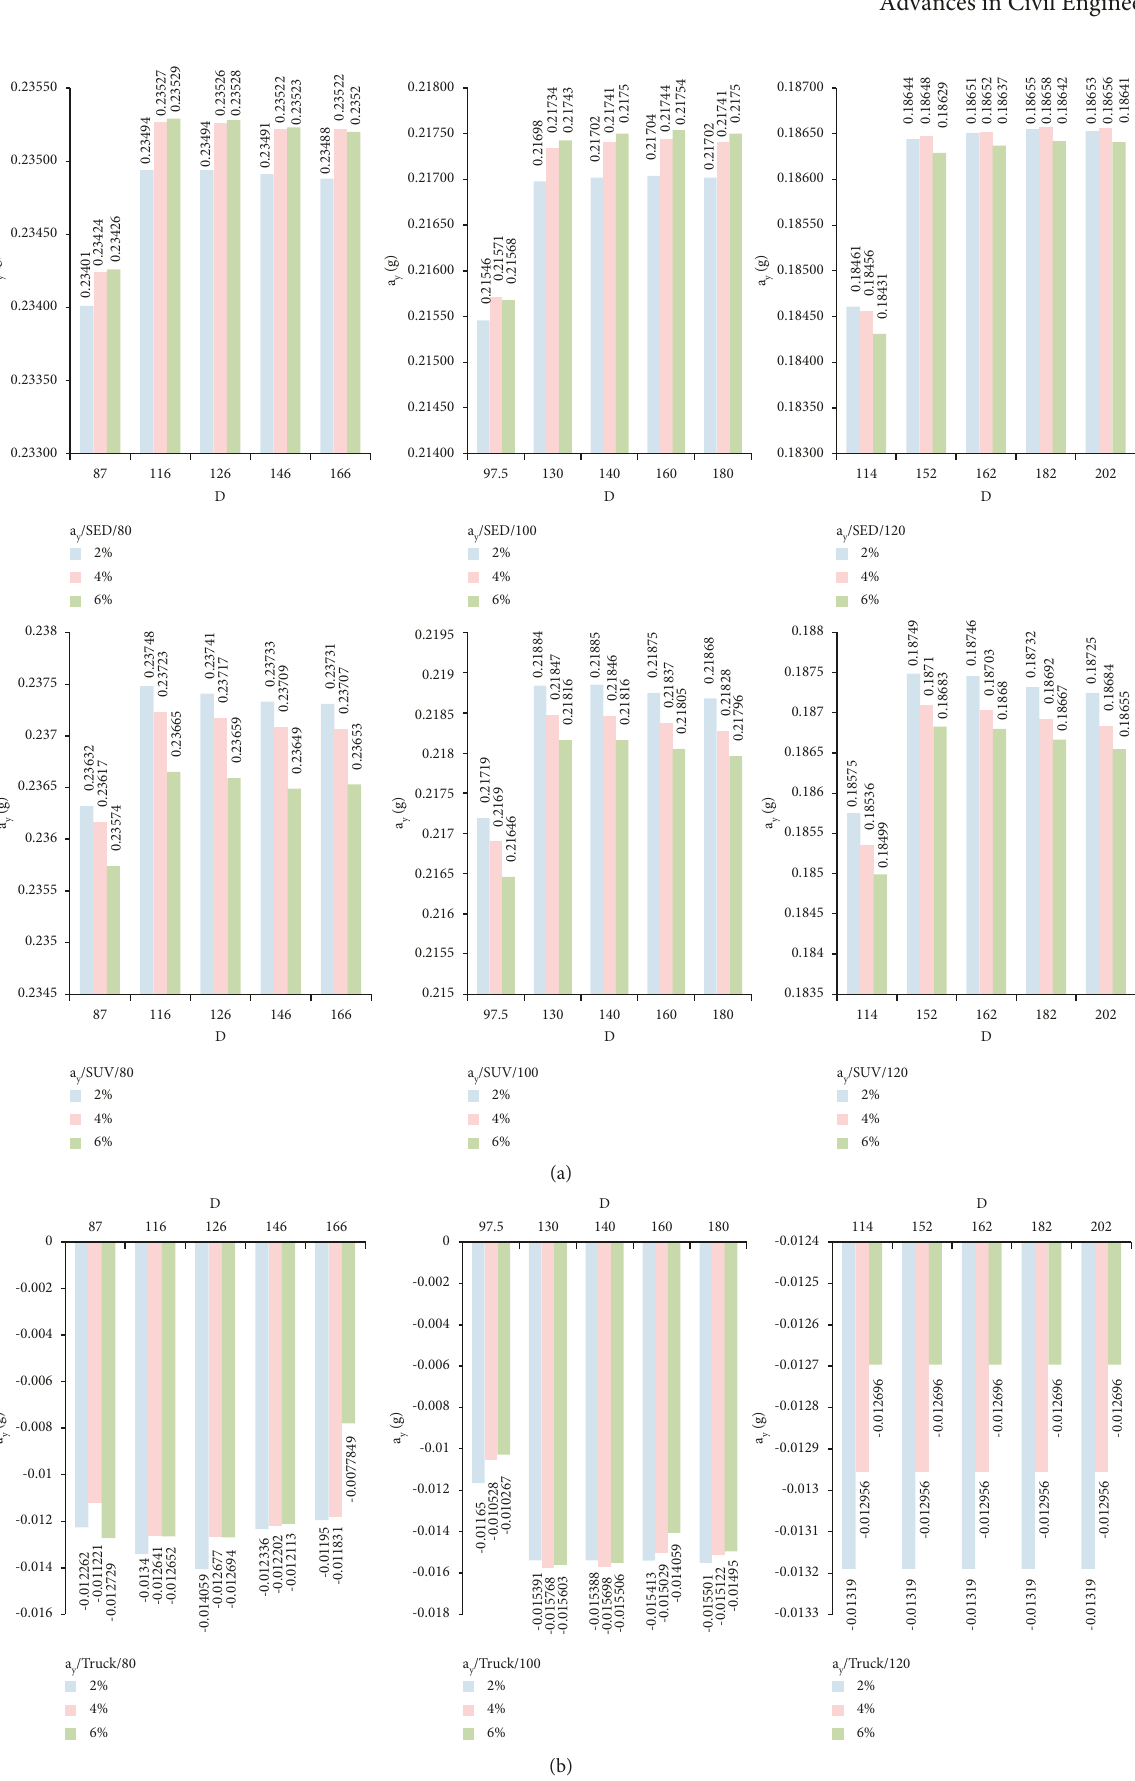
Figure 2: Lateral acceleration changes when direct distance changes at upgrades and speeds of 80, 100, and